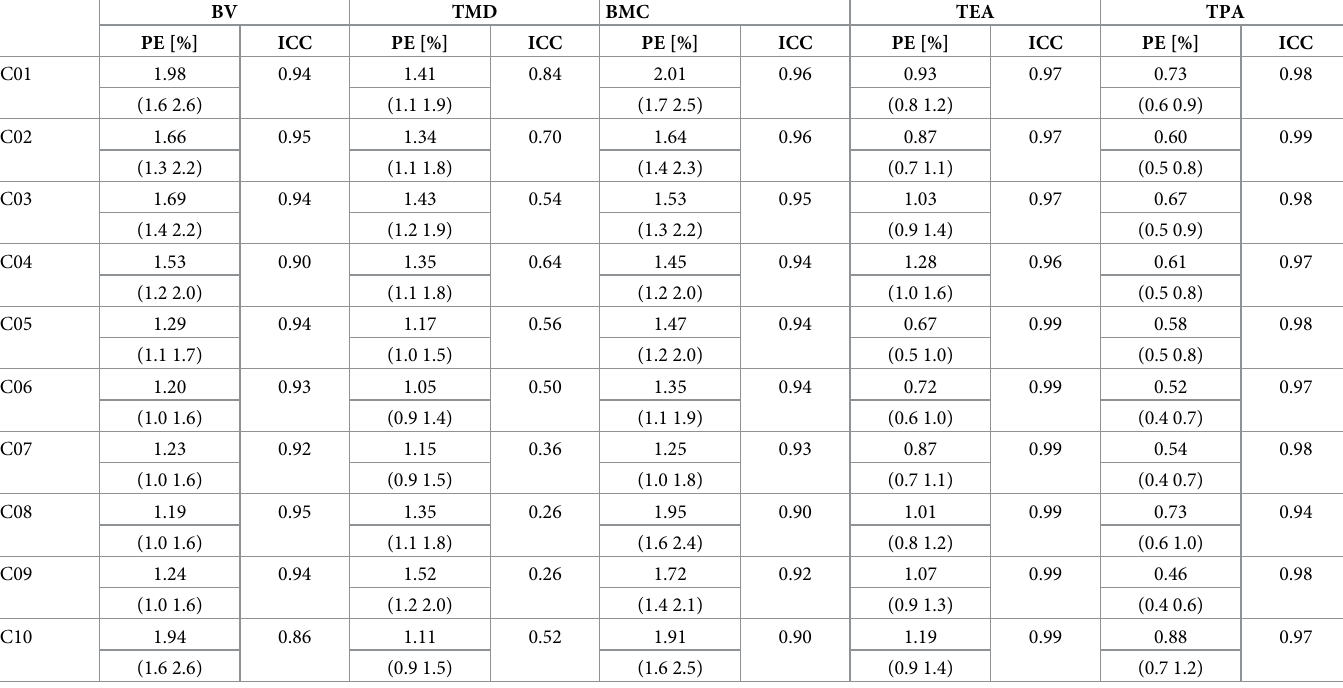
Table 1. Reproducibility of BV, TMD, BMC, TEA and TPA expressed in mean precision errors (PE) as coefficients of variation (the 95% confident intervals shown in Parentheses), and the intraclass correlation coefficients (ICC) (C01 –C10 corresponds to the proximal to distal sides of the tibia, see Fig